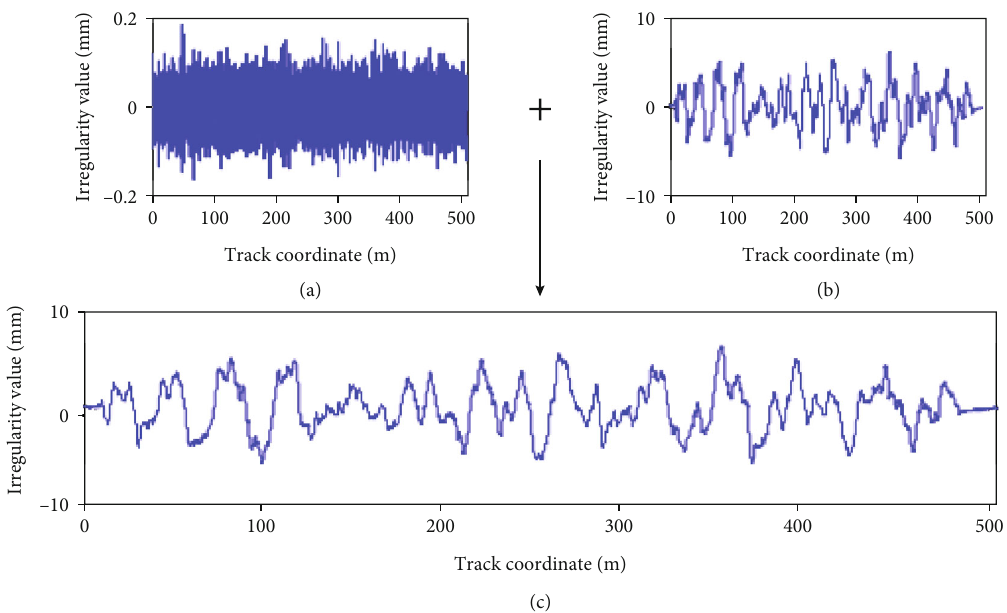
Figure 2: Samples of the short-wavelength random track irregularity [26] (a), medium-long-wavelength random track irregularity (b), and combined random track irregularity (c).